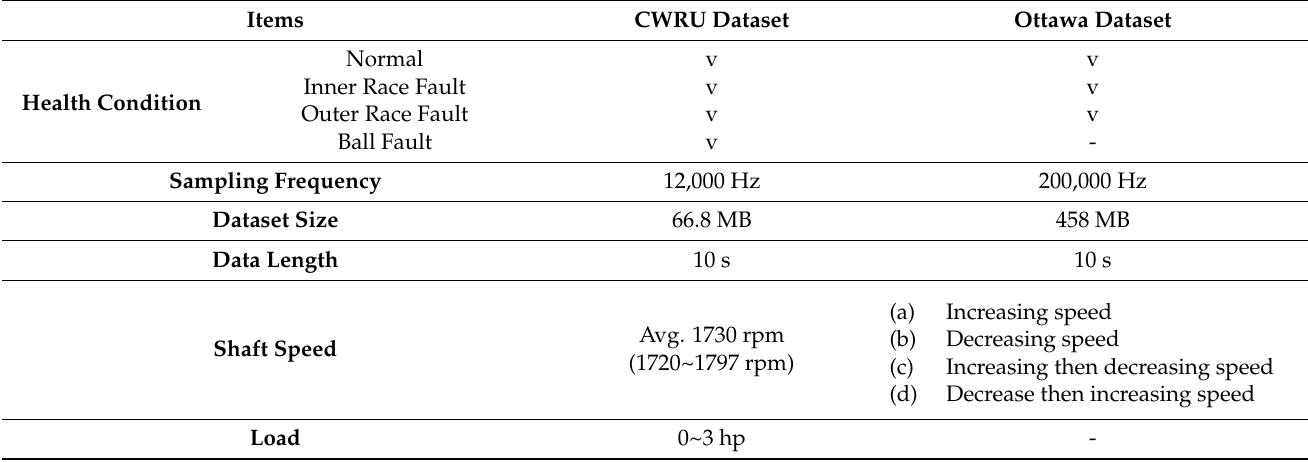
Table 2. Comparison between CWRU with